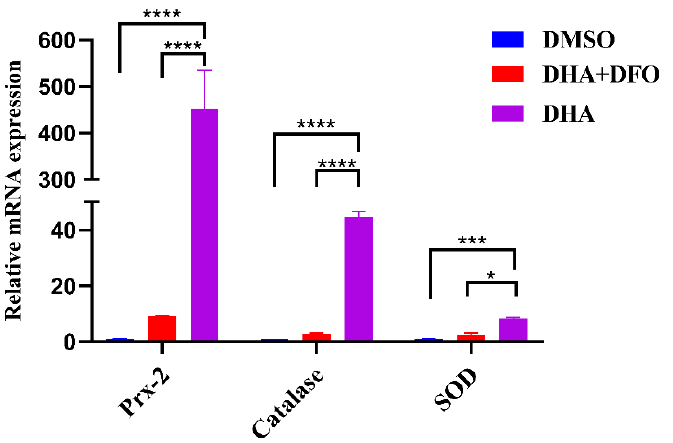
Figure 4. qPCR analysis of antioxidant genes. Equal amounts of fresh tachyzoites were inoculated into Vero cells and grown for 12 h. Tachyzoites were collected for qRT-PCR analysis after 24 h of treatment with 0.88 μM DHA, DHA + DFO , or DMSO. Experiments were performed in three independent experiments. Student’s t -tests were used for this analysis (* p < 0.05, *** p < 0.001, and **** p <